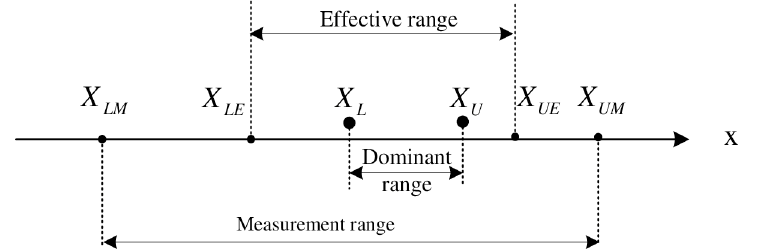
Fig 1. Range Segmentation